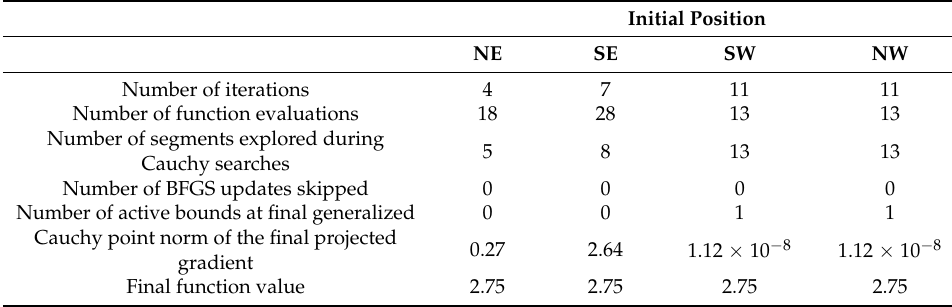
Table 2. Summary of the